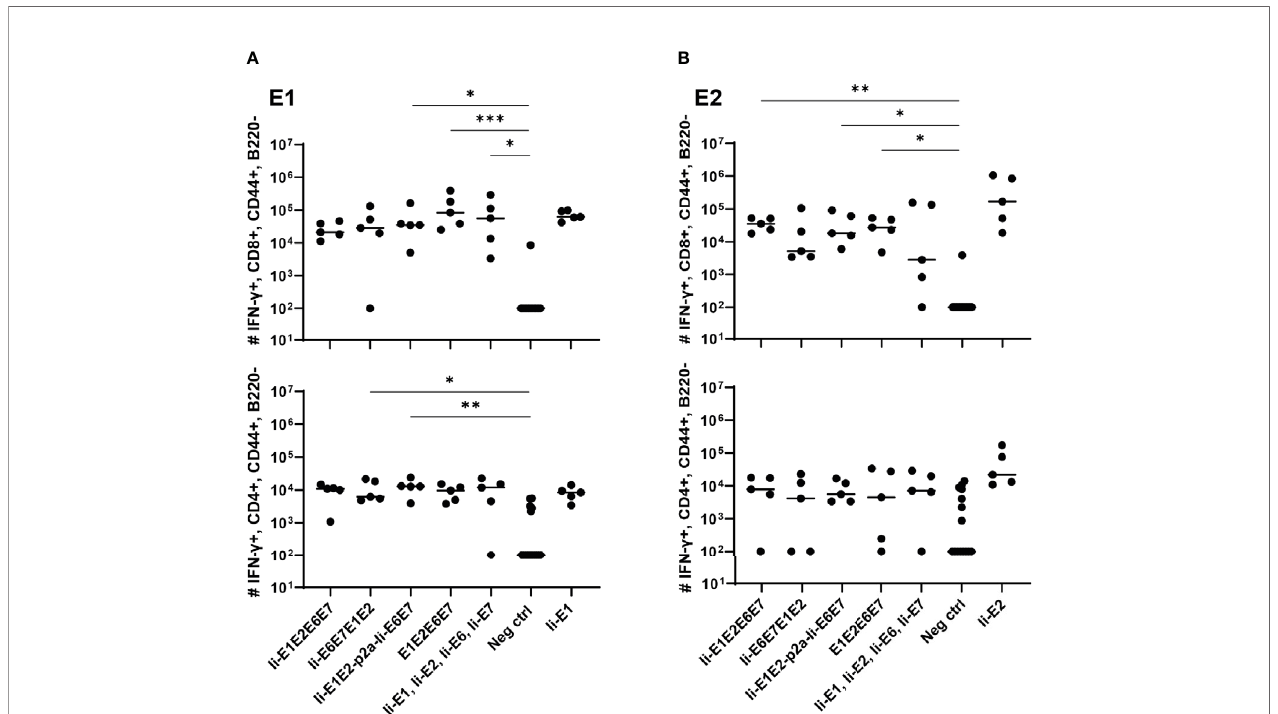
FIGURE 3 | T cell responses induced by the various pURVac DNA vaccines encoding E1, E2, E6 and E7 in outbred CD1 mice. CD1 mice (5 per group) were immunized 4 times in 1 week intervals with 0.5 µg DNA of pURVac DNA encoding the indicated MfPV3 early antigens. Mice were sacri fi ced 7 days post last immunization, spleens were harvested and CD8 + (top panels) and CD4 + (bottom panels) T-cell immune responses against E1 (A) , and E2 (B) were measured using ICS and fl ow cytometry. Negative control groups consist of all mice immunized with a pURVac DNA vaccine encoding antigens not covered by the peptide pools used for in vitro restimulation. Asterisks between groups indicate signi fi cant differences in response-levels after subtraction of background responses. Each symbol represents one mouse; the horizontal bar represents the median. Reference samples (mice vaccinated with pURVac DNA vaccine containing only the individual antigen linked to Ii, respectively) are not included in the statistical analysis (multiple comparison adjustment). *p < 0.05; **p < 0.01, ***p <